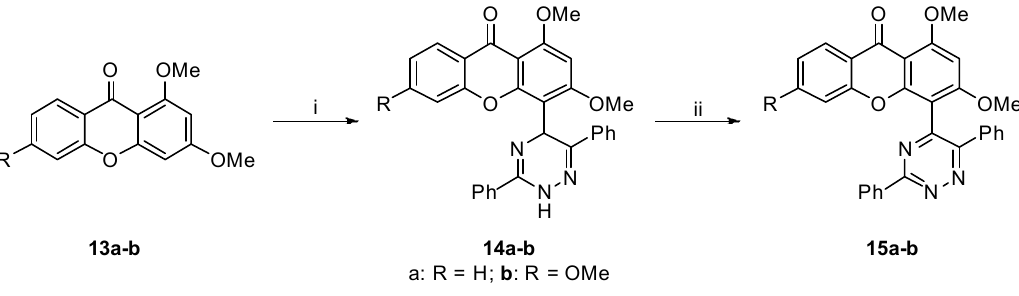
Scheme 5. Synthesis of dihydrotriazine-substituted 1,3-dihydroxyxanthones 14a – b and 15a – b .